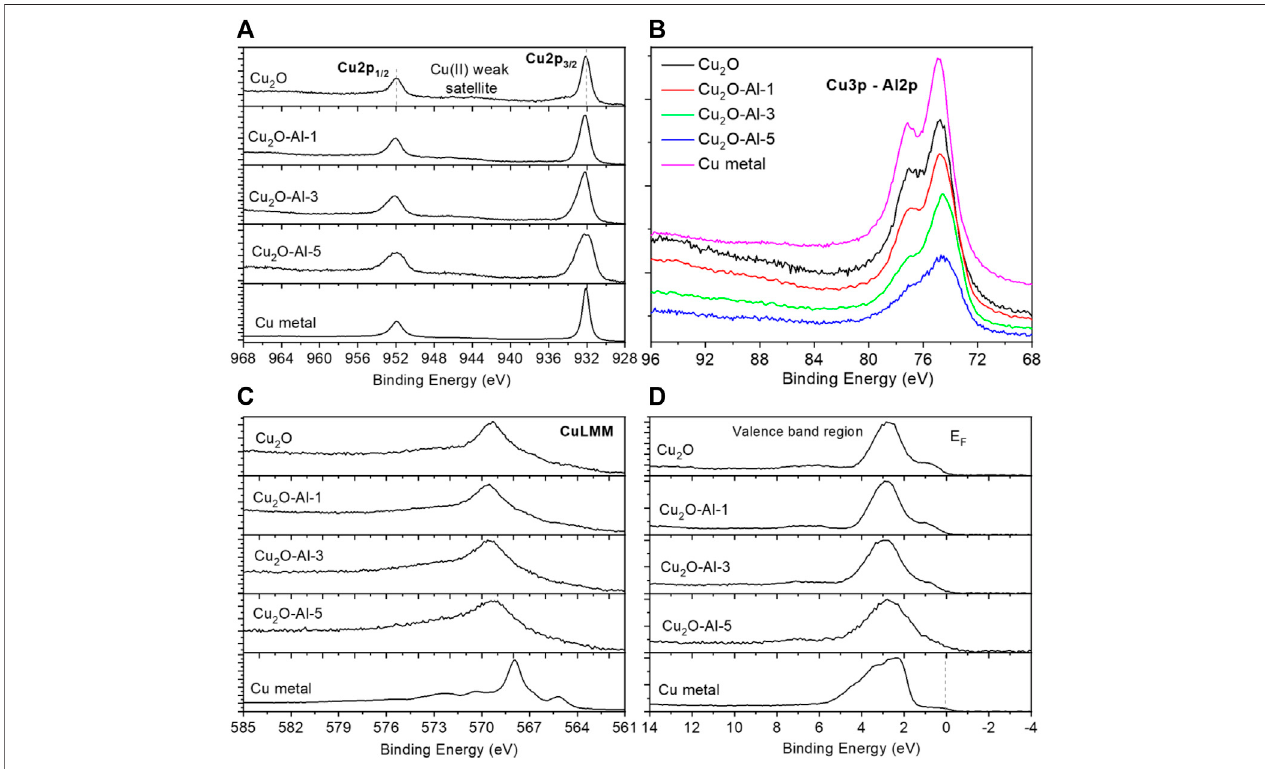
FIGURE 3 | XPS spectra of (A) Cu2p doublet, (B) Cu3p and overlapping Al2p region, (C) CuLMM Auger peaks and (D) valence band regions (E F stands for Fermi Energy level) for Cu 2 O, Cu 2 O-Al-1/3/5 and Cu metal reference samples.